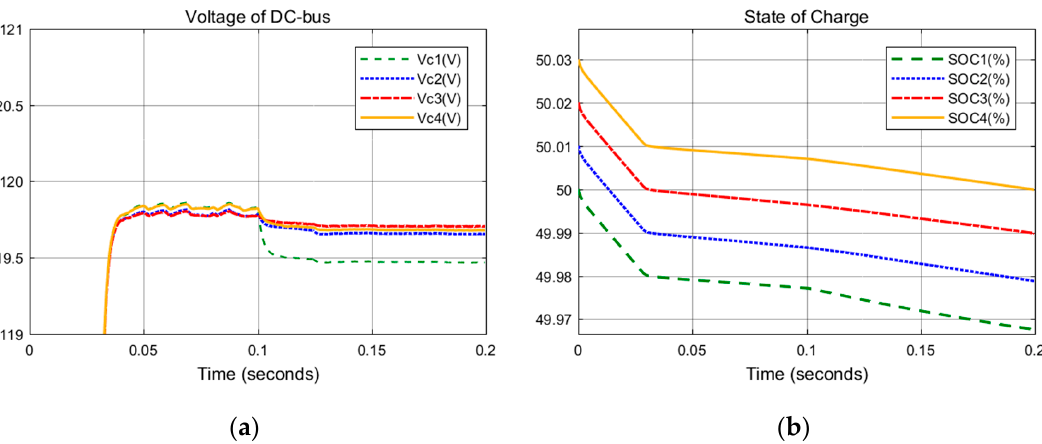
Figure 10. Only with the primary control when failure at 0.1 s of DCES1: ( a ) DC-bus voltage; ( b ) battery SOC.